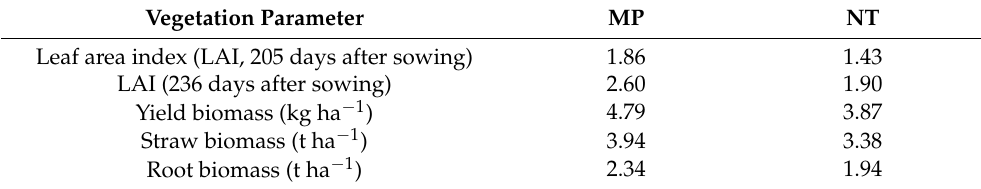
Table 14. Vegetation parameters collected after harvest in moldboard ploughing (MP) and no-tillage (NT) treatments. Vegetation Parameter Leaf area index (LAI, 205 days after